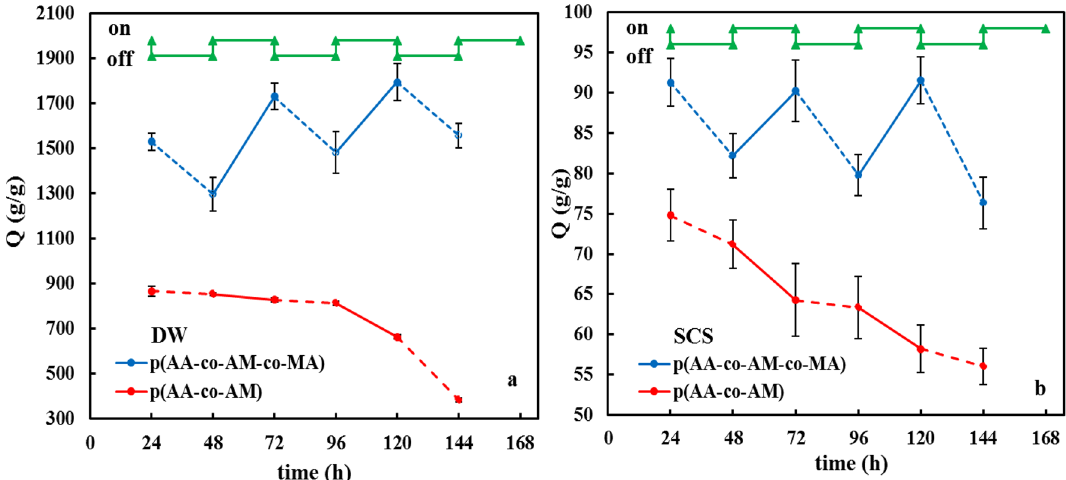
Figure 11. The reversible T-controlled on–off switching for the superabsorbents in ( a ) DW and ( b ) SCS. The time interval between the changes was 24